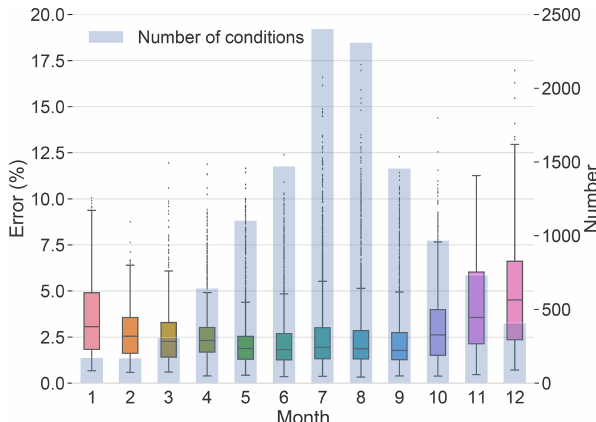
Figure 6. Monthly distribution of the testing results (errors com- pared with MCM) of the Rdc. mechanism in the box plot as well as the number of testing conditions in the